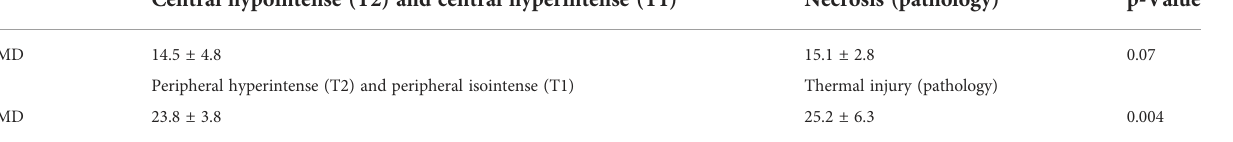
TABLE 3 Comparison of MD of MR performance and pathology after thermal ablation (mm). Central hypointense (T2) and central hyperintense (T1)